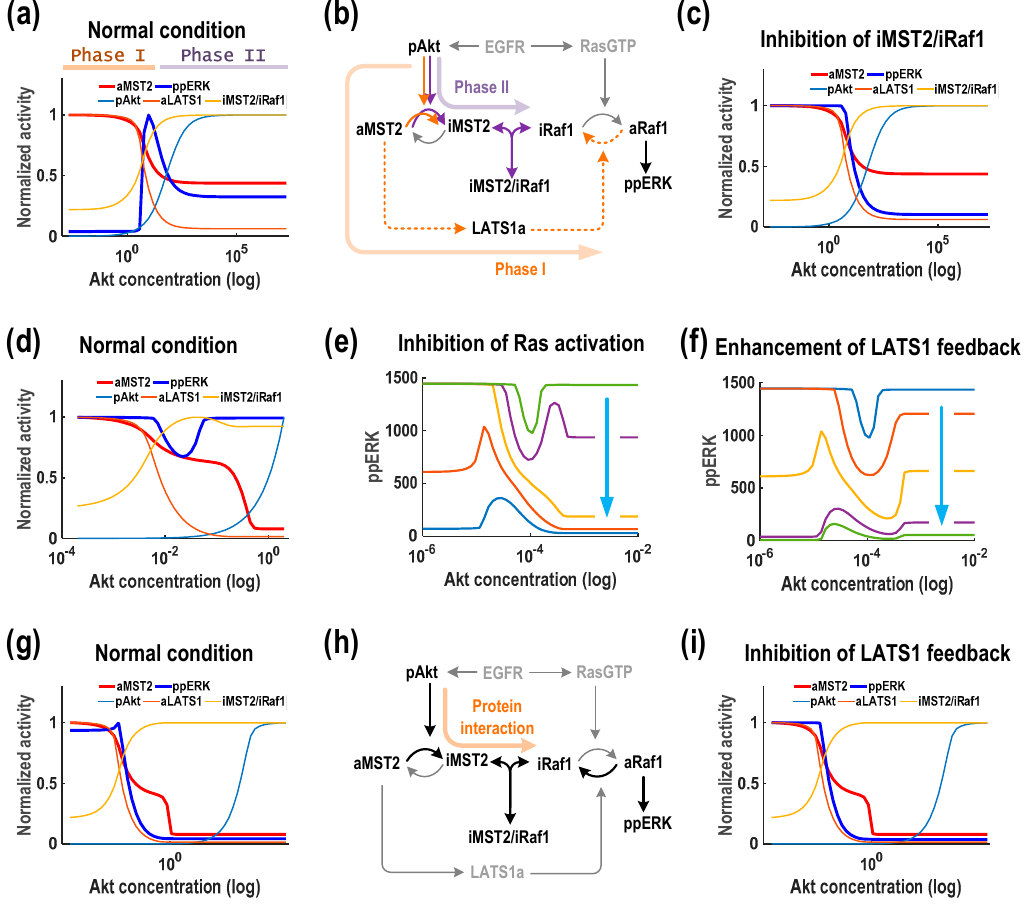
Figure 5. Akt generates diverse ERK response patterns. ( a – c ) The pattern M1E3 where Akt downregulates MST2 activity and induces a biphasic (concave ‐ down) response of ERK activity; ( d – f ) The pattern M1E4 where ERK activity displays the type II biphasic (concave ‐ up) response against increasing Akt; ( g – i ) The pattern M1E1 in which Akt consistently inhibits both ERK and MST2 activation. Note that the response profiles to Akt were generated using a representative parameter set that show the same patterns as in Figure 4 (see Supplementary Materials Table S4).